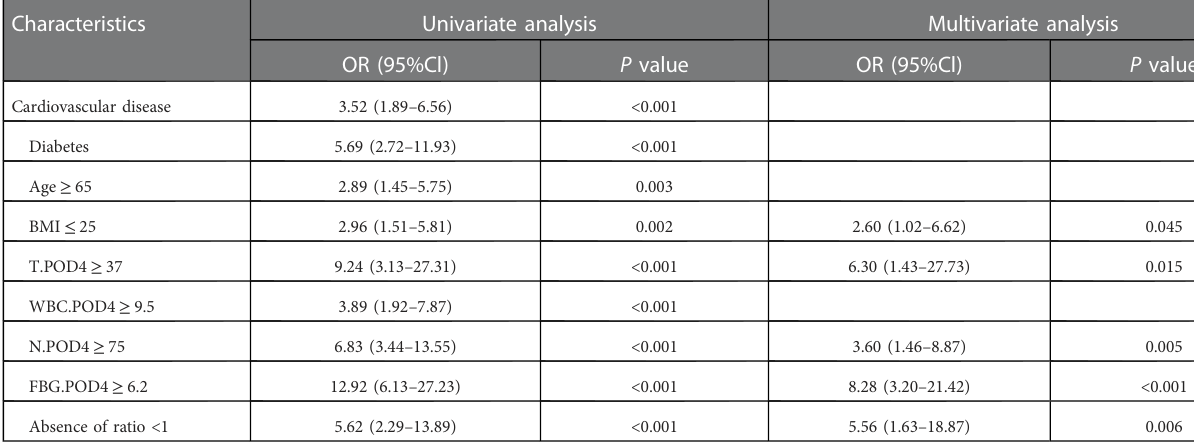
TABLE 5 Univariate and multivariate analysis for POD7 complication in the training